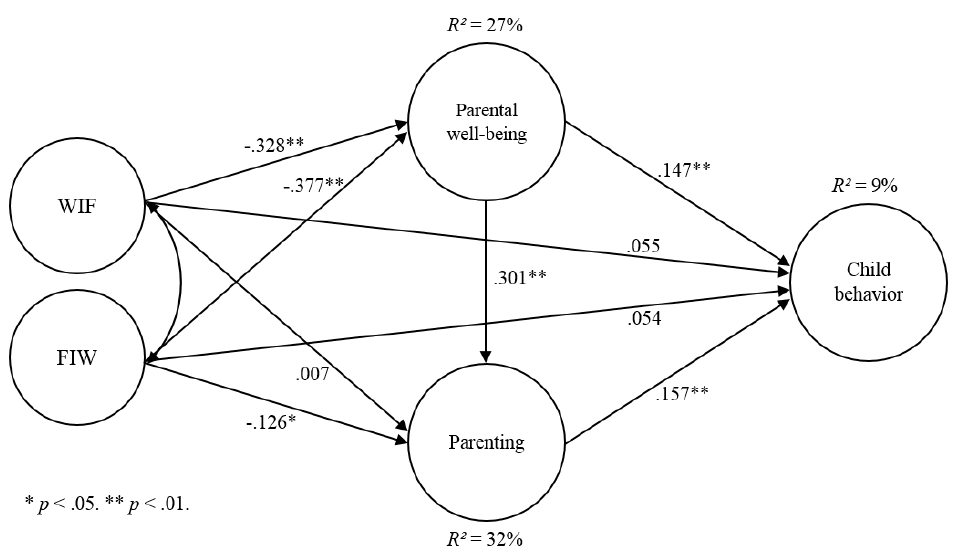
Structural model: Directional